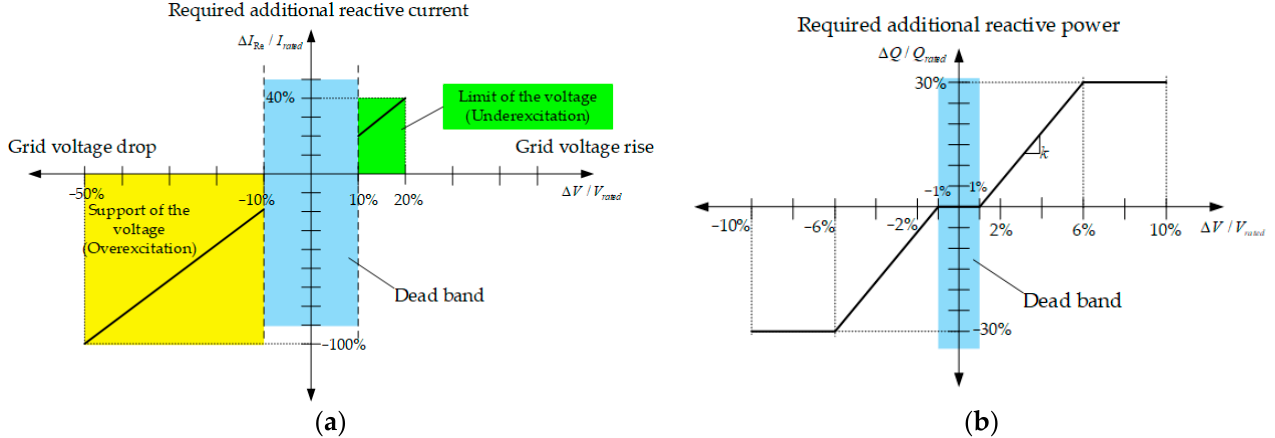
Figure 2. German Grid Code: ( a ) principle of grid voltage support; ( b ) reactive current to grid voltage regulation.